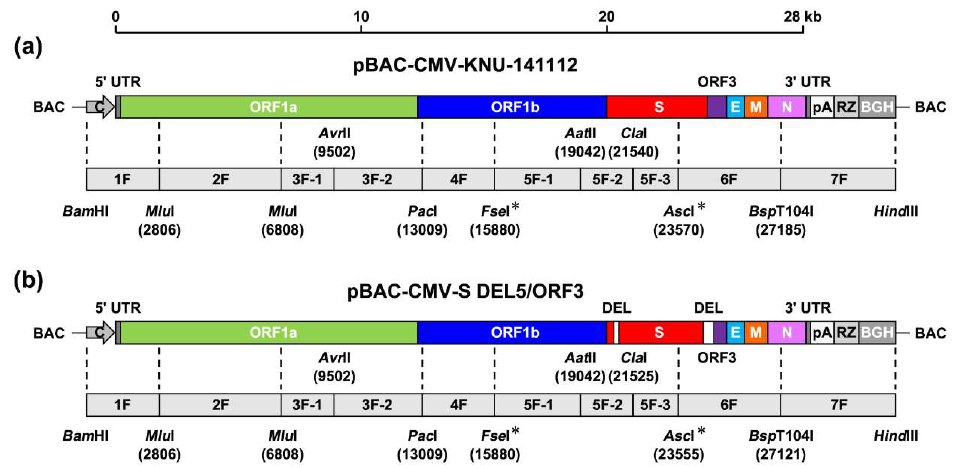
Figure 1. Strategy for the construction of two full-length molecular clones of PEDV strains, KNU-141112 and S DEL5/ORF3, in a BAC system. The illustration at the top of each panel represents the full-length cDNA genome organization of HP-G2b KNU-141112 ( a ) or LAV S DEL5/ORF3 ( b ). Viral genes (ORF1a, ORF1b, S, ORF3, E, M, and N) are illustrated by different colored boxes in each genome scheme. The CMV promoter (C), HDV ribozyme (Rz), and BGH transcription terminal sequences (BGH) are also shown in each genome diagram. 5′ and 3′ UTR, 5′ and 3′ untranslated regions; pA, poly(A) tail (26-nt). DEL on the S DEL5/ORF3 genome schematic represents the 15-nt (left) and 46-nt (right) DEL signatures. The second diagram in each panel represents seven overlapping cDNA fragments, termed 1F to 7F, covering the full-length genome of each strain, which were sequentially cloned into the plasmid pBAC-CMV to generate the PEDV infectious clones pBAC-CMV-KNU-141112 ( a ) and pBAC-CMV-S DEL5/ORF3 ( b ). The relevant restriction sites used for the assembly of the infection clone and their genomic positions (first nucleotide of the recognition sequence) are indicated. The Bam HI and Hind III sites existed in the multiple cloning site of the backbone vector pBAC-CMV. Two rescue markers, Fse I and Asc I sites, which were created by introducing silent mutations, are indicated by asterisks.